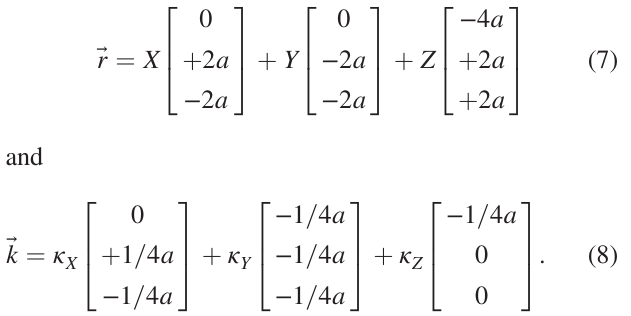
ffiffiffiffiffiffiffiffiffiffiffiffiffiffiffiffi 3 j m j = 2 t